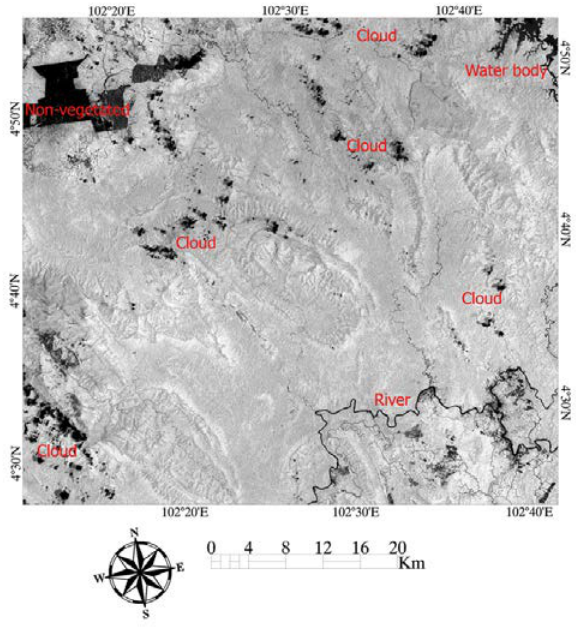
Figure 3. StVI resultant image map of vegetation for the study